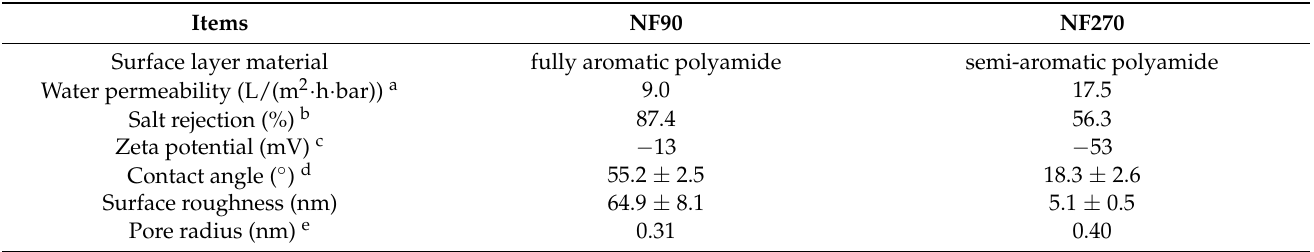
Table 2. Characteristics of NF 90 and NF270